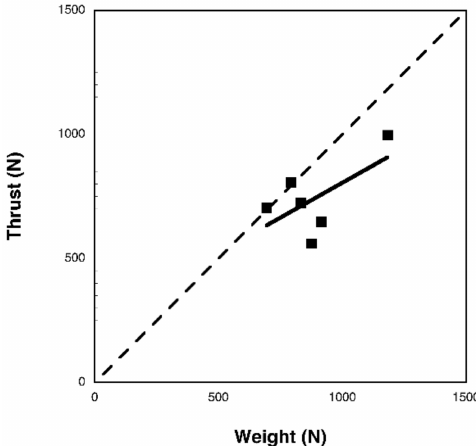
Figure 4. Plot of thrust measured using bubble DPIV with respect to weight supported out of the water. The solid line represents the regression of the data collected. The dashed line is line of equality for thrust produced to support the weight of the dolphin above the surface of the water during a tail